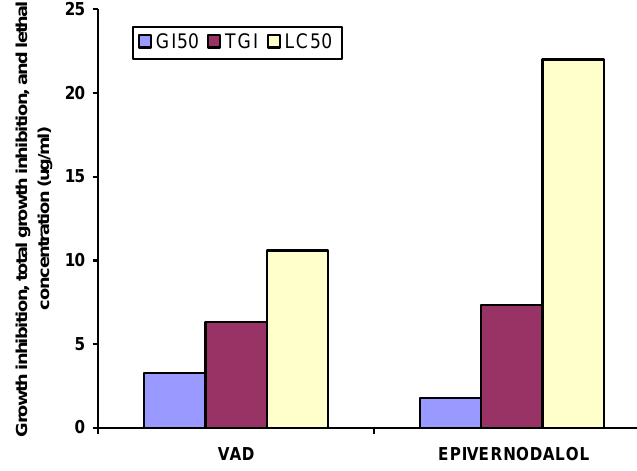
Figure 3. Each value represents the means ± SD of three independent experiments. GI = Growth inhibition of 50% of the cells; TGI = Total growth inhibition; 50 LC = Lethal concentration of the compound/extract that kills 50% of the cells; MEVA: 50 methanolic extract of Vernonia amygdalina ; VAP: petroleum ether fraction; VAD: dichloromethane fraction . (Adapted from Owoeye et al.